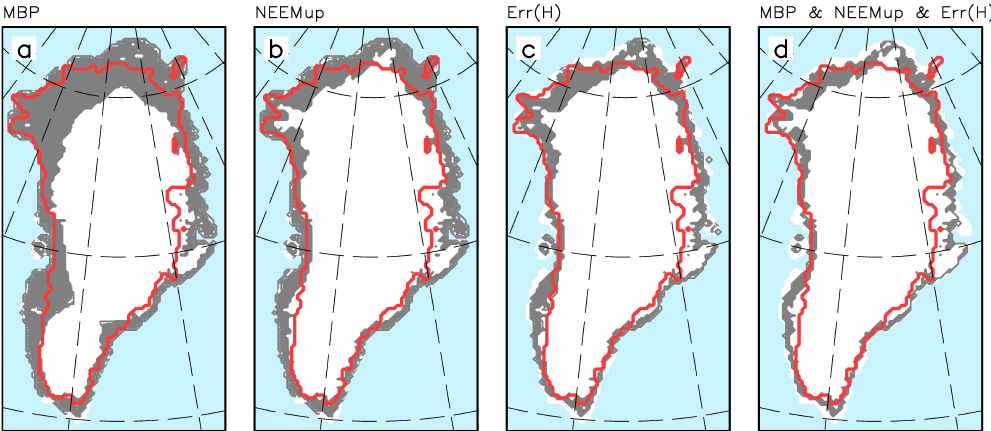
Figure 6. Simulated geographical position of present-day ice margins for simulations with the discharge parameterization (gray areas) compared to observations (red line). The gray shaded areas cover the range of simulated ice margins determined by different constraints. (a) – (c) Single constraint applies: (a) mass balance partition, (b) elevation reduction during the Eemian referenced to present day at the upstream position of NEEM, and (c) error in ice thickness. (d) All three constraints